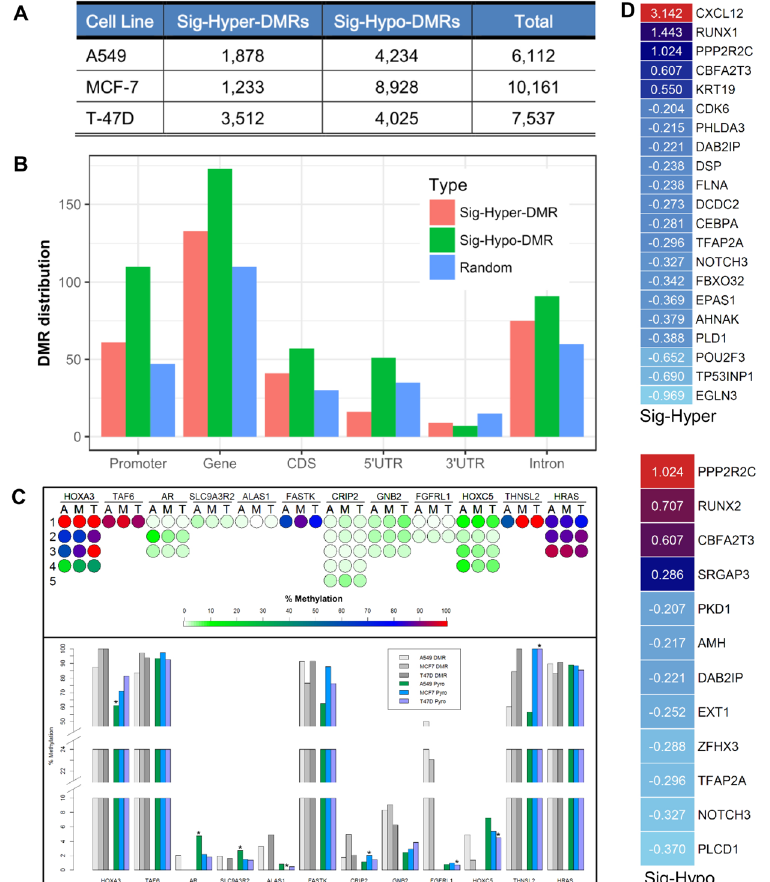
Figure 3. Genome-wide interrogation of significant differentially-methylated CpG sites and regions across 19 cell types. ( A ) The significantly hyper- and hypo-DMRs identified from three benchmark cell types, A549, MCF-7 and T-47D; ( B ) The identified TSGs’ components overlapping with Sig-Hyper-DMR and Sig-Hypo- DMR in T-47D; ( C ) Upper panel: DNA methylation pattern of 12 genes in the first 1~5 CpG sites has been detected by pyrosequencing (A: A549; M: MCF7; T: T47D). Lower: average of pyrosequencing detected %Methylation of 1~5 CpG sites for 12 genes in the three cell lines (A549 Pyro: green, MCF7 Pyro: sky blue, T47D Pyro: dark purple) and their DMRs (A549 DMR: light gray, MCF7 DMR: medium gray, T47D DMR: deep gray). Asterisk represents the results as algorithm expected; ( D ) The differential expression status for the investigated TSGs using RNA-seq data (left panel: Sig-Hyper-DMRs; right panel: